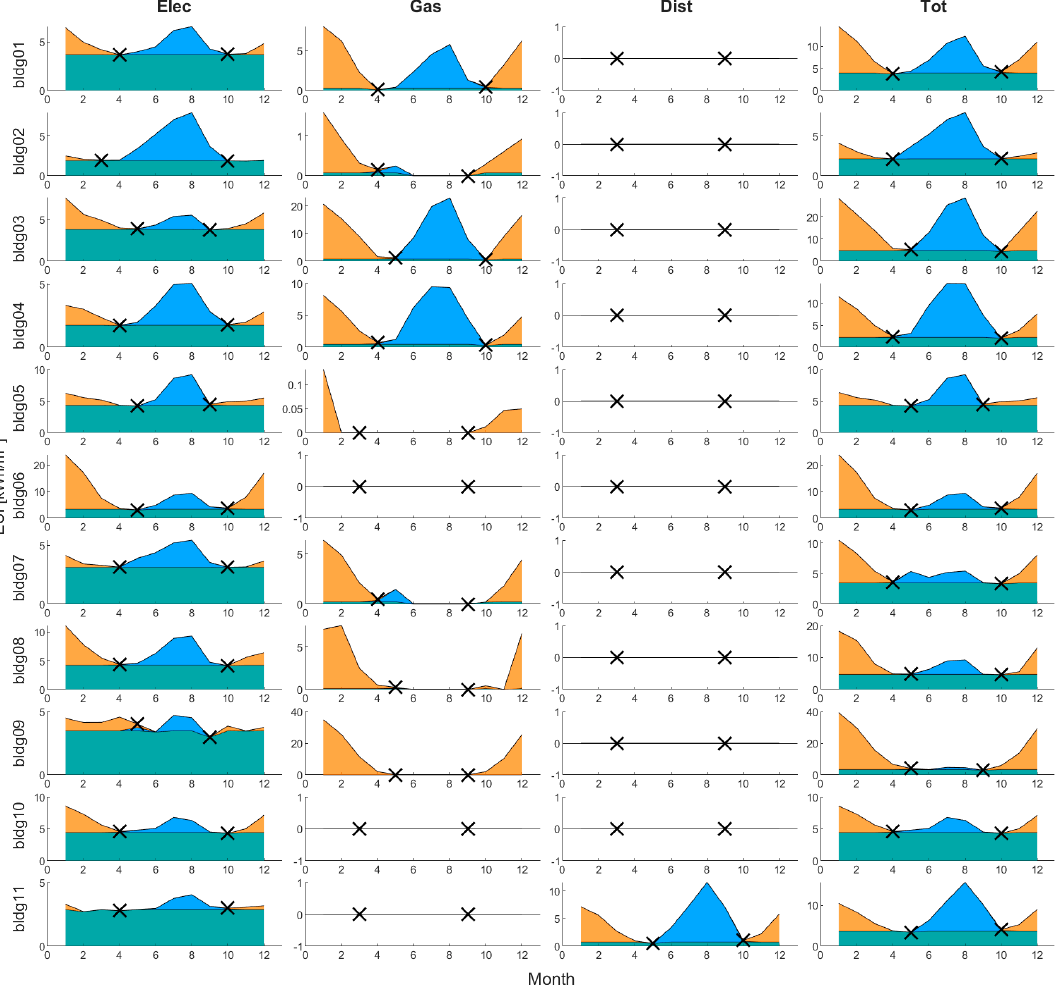
Figure 8. SED results by energy sources (blue: 𝐸𝑐 ; orange: 𝐸ℎ ; green: 𝐸𝑏 ). The markers (X) are estimated shoulder points ( f , s ) at spring and autumn seasons.